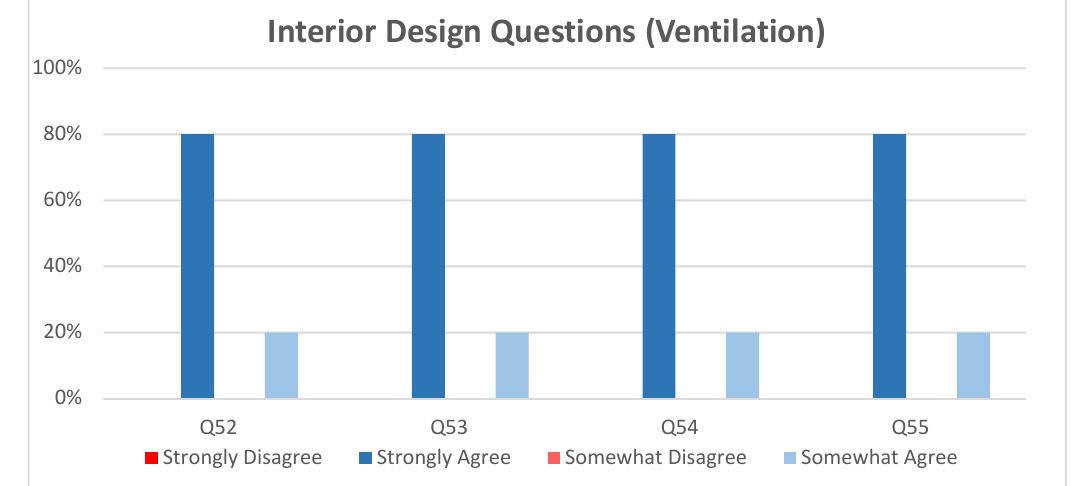
Table 11. Interior design questions (aesthetic and decorative design) . Figure 14. Results for the questions on ventilation. Figure 14. Results for the questions on ventilation.